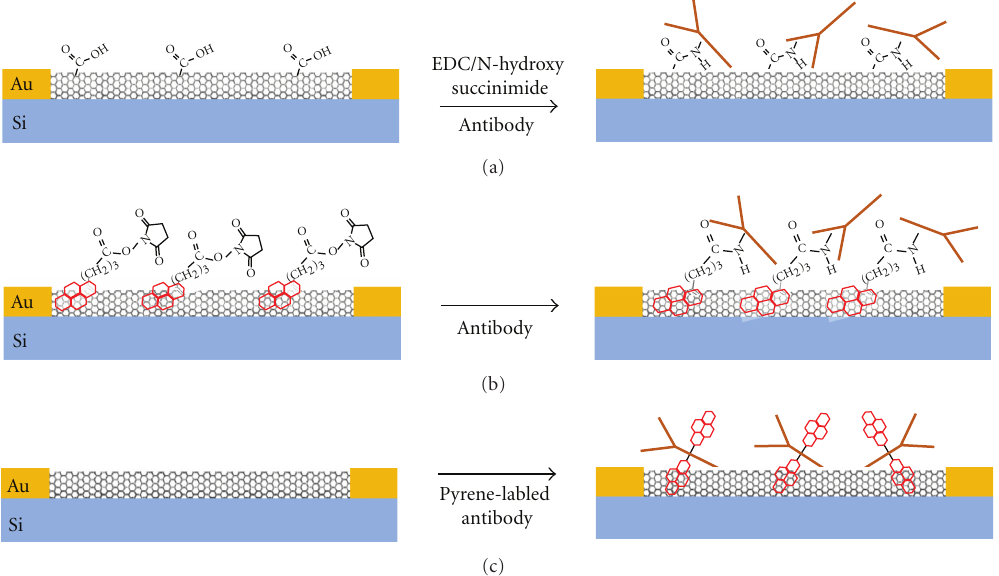
Figure 2: Depiction of the CNT-FET antibody functionalization procedures used in this study. (a) EDC/N-Hydroxy succinimide modification of endogenous CNT carboxyl groups ( left ). Using this method the antibody is attached to the CNTs via zero-length coupling ( right ). (b) Pyrenebutanoic acid succinimide esters addition to CNTs ( left ), which mediate attachment to antibody primary amine groups via a four carbon spacer ( right ). (c) Addition of pyrene-hydrazide modified antibodies to bare CNT-FETs ( left ), which can lead to uniform antibody orientation on the circuits ( right ).